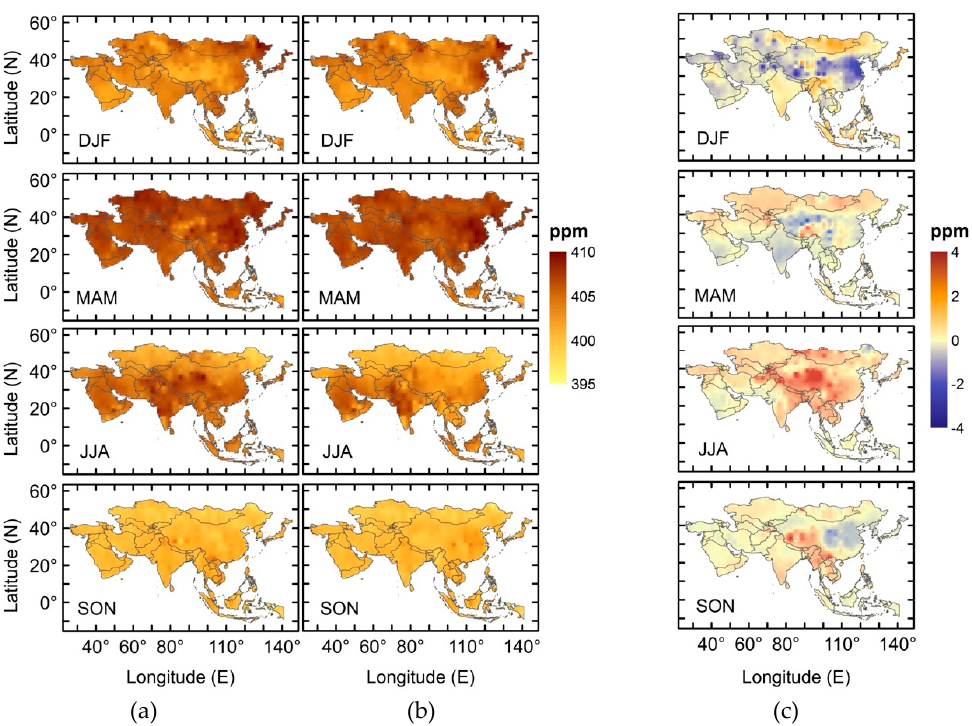
Figure 9. Seasonal distribution of XCO 2 from the CT (left panel), OCO-2 (middle panel), and their differences (CT-OCO2) (right panel). Table 9. The table shows the seasonal statistics of the CT and OCO-2 for 4 years over Asia and its regions. The statistics are based on the seasonal average of the difference between the CT and OCO-2 (D), correlation, RMSD, and the standard deviation.